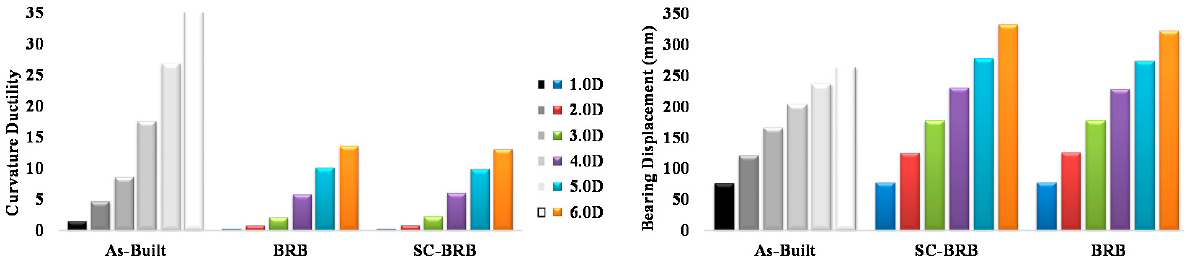
Figure 23. Observed CD ( left ) and BD ( right ) demands under far-field earthquake records when scaled to different design intensities.